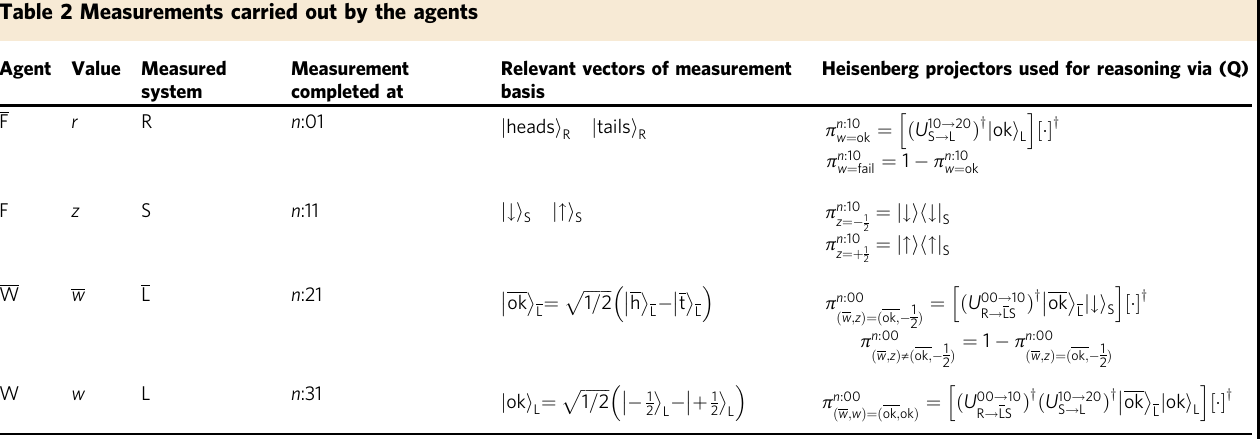
Eachofthefouragentsobservesavalue,de fi nedastheoutcomeofameasurementonaparticularsystemataparticulartime.Themeasurementbasisvectors ok according to Assumption (Q). These operators are given in the Heisenberg picture, referring to the system ’ s state at a particular time, which is specied by a superscript. The bracket (cid:5)½ (cid:6) y stands for the adjoint of the preceding